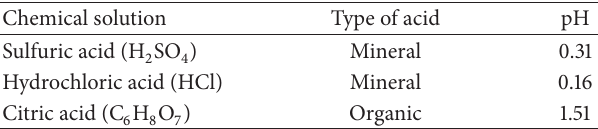
Table 1: Acid solutions used for microconcretes exposure.